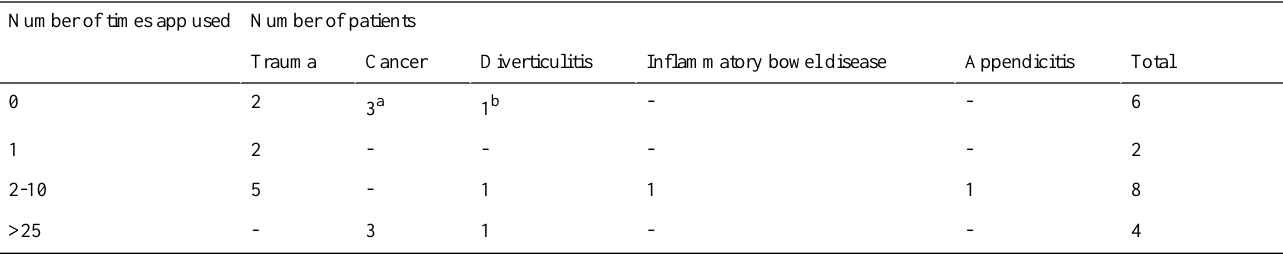
Table 2. Number of app uses and surgical diagnoses.